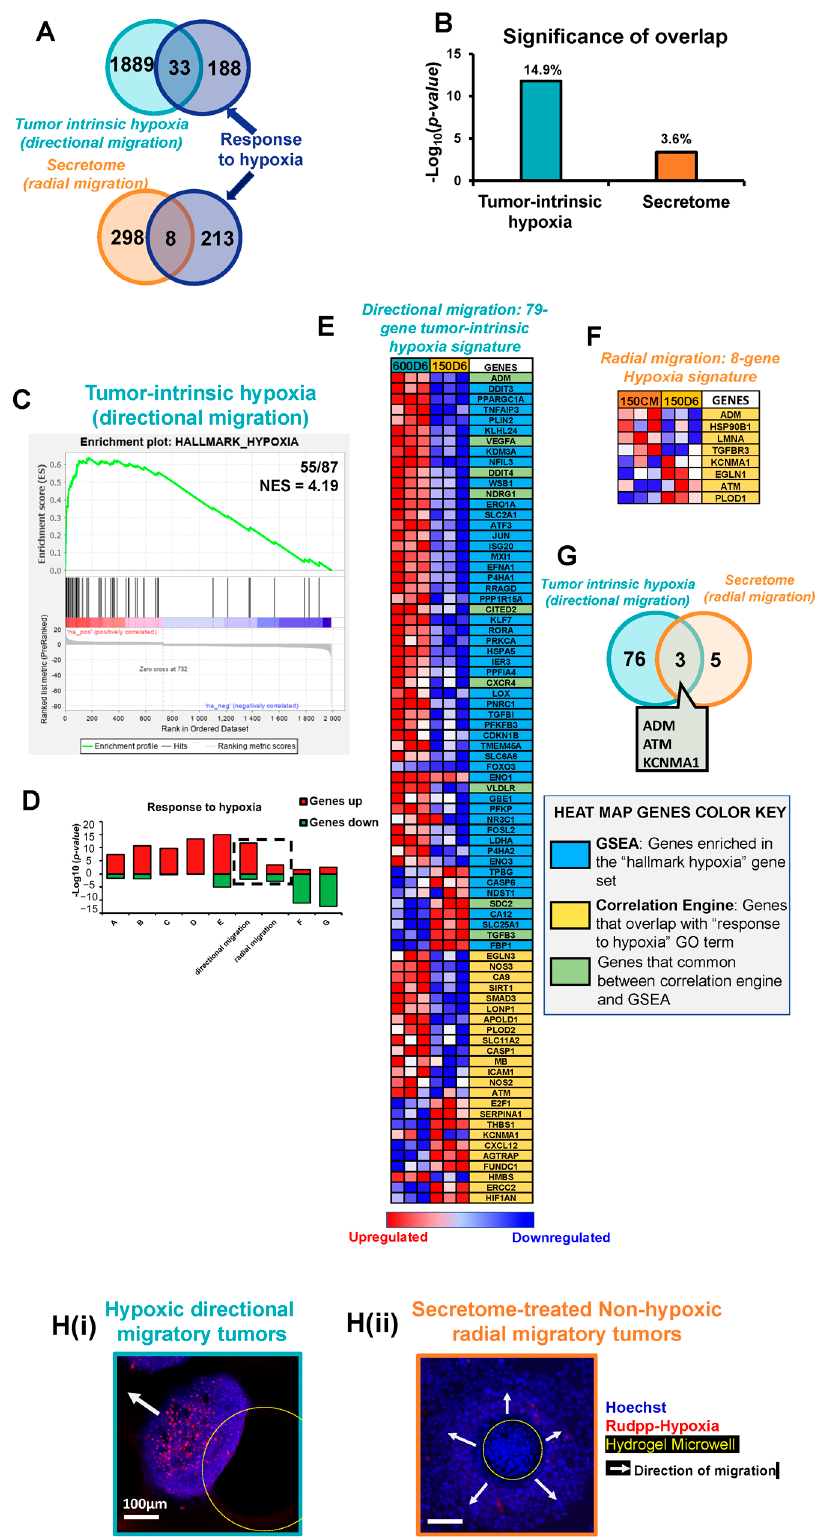
Figure 3. Hypoxia is highly enriched in large migratory tumors as compared to small migratory tumors. ( A ) Venn diagram of correlation engine analysis showing the 33 common genes between tumor intrinsic hypoxia-induced directional migration and ‘response to hypoxia’ gene ontology